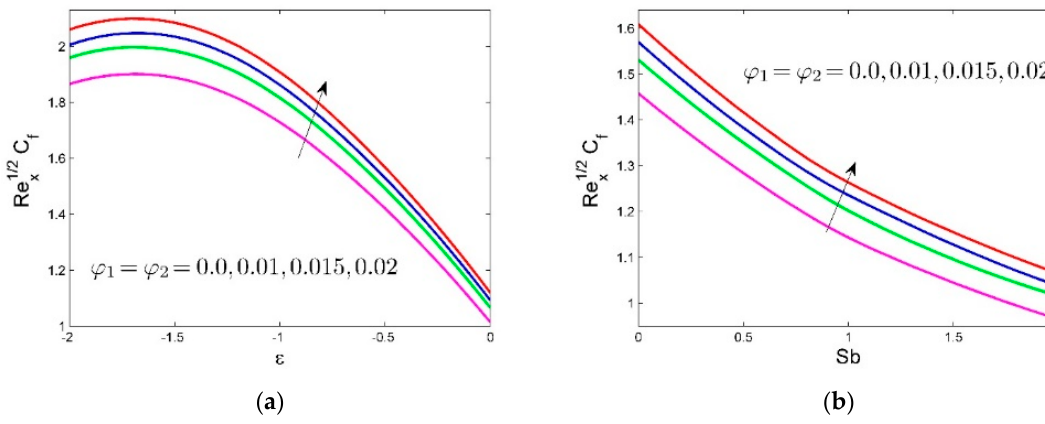
Figure 8. Impacts of 𝜑 (cid:2869) and 𝜑 (cid:2870) against ε and Sb on C f . Heat transfer rate increases against shrinking parameter and Stefan blowing when a rise in the nanoparticle volume fraction of 𝜑 (cid:2869) and 𝜑 (cid:2870) up to 2% as compared to regular fluid ( 𝜑 (cid:2869) = 𝜑 (cid:2870) = 0 ) . Physically, an upsurge in the 𝜑 (cid:2869) and 𝜑 (cid:2870) against shrinking parameter and Stefan blowing leads to the thermal conductivity accelerated, which causes a rise in the heat transfer rate. This is due to the synergistic effects of HNF (see Figure 9a,b).